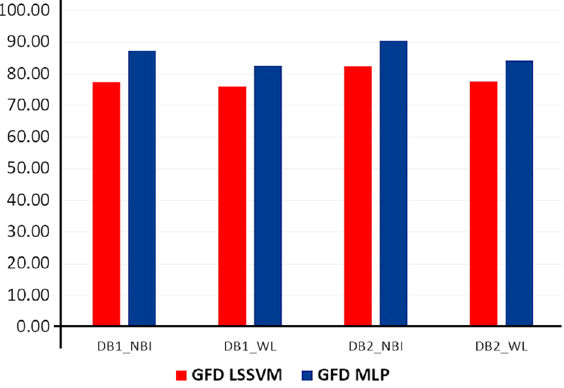
Figure 3. Result of shape features before feature selection.